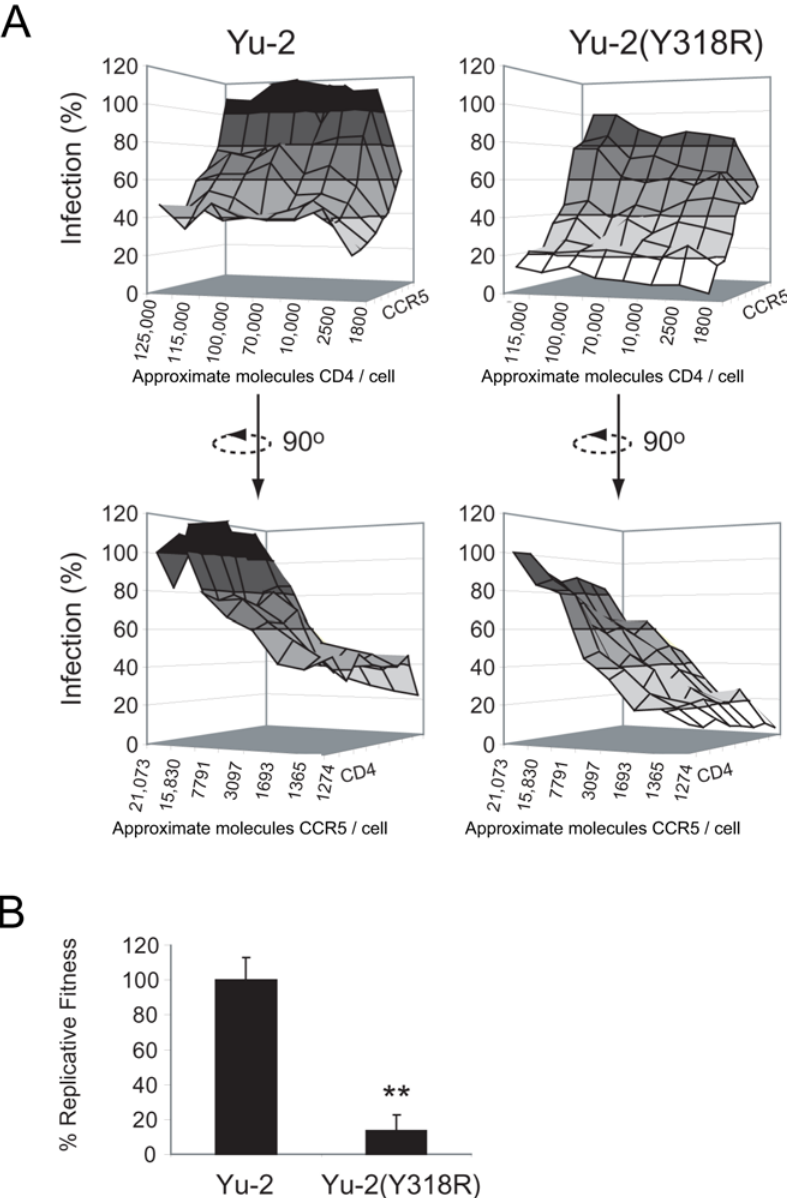
Figure 1. Affinofile cells allow for the analysis of both CD4 and CCR5 usage and are a surrogate marker of fitness. (A) Affinofile cells were infected with Luciferase-encoding envelope psudotyped viruses bearing the envelope of the neurotropic lab strain Yu-2 or a V3-crown mutant [Yu-2(Y318R)] with reduced CCR5 usage. Surface plots were constructed using infectivity data derived from luciferase activity. Percent infection (y- axis) was derived from the luciferase activity at each receptor expression combination divided by the luciferase activity at maximal CD4/CCR5 expression levels. The x-axis depicts approximate CD4 expression level described as approximate molecules CD4/cell as assessed by quantitative flow cytometry (top 2 panels), and the z-axis depicts approximate CCR5 expression levels (bottow 2 panels). (B) Relative replicative fitness of full length HIV-1 viruses in multiple replication cycle in primary PHA/IL-2–activated peripheral blood mononuclear cells. The replicative fitness of full length Yu-2 and Yu-2(Y318R) was determined by pairwise infection and quantification of relative outgrowth. The y-axis represents percent replicative fitness of Yu-2(Y318R) relative to Yu-2.